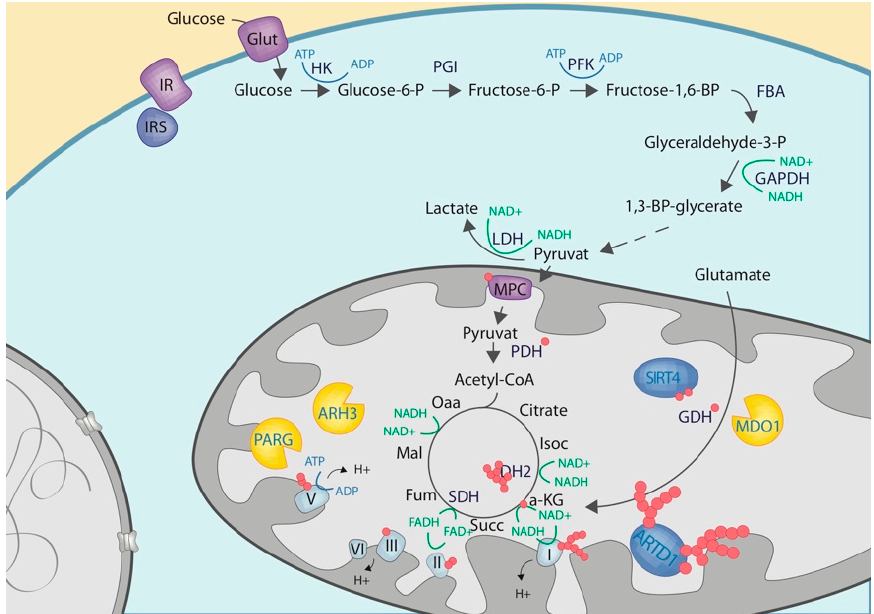
Figure 3. Schematic overview on the functional contribution of mitochondrial ARTs to carbohydrate metabolism. Metabolic pathways are shown as in Figure 1. ADP-ribosyltransferases are depicted in blue, while ADP-ribosylhydrolases are depicted in yellow.